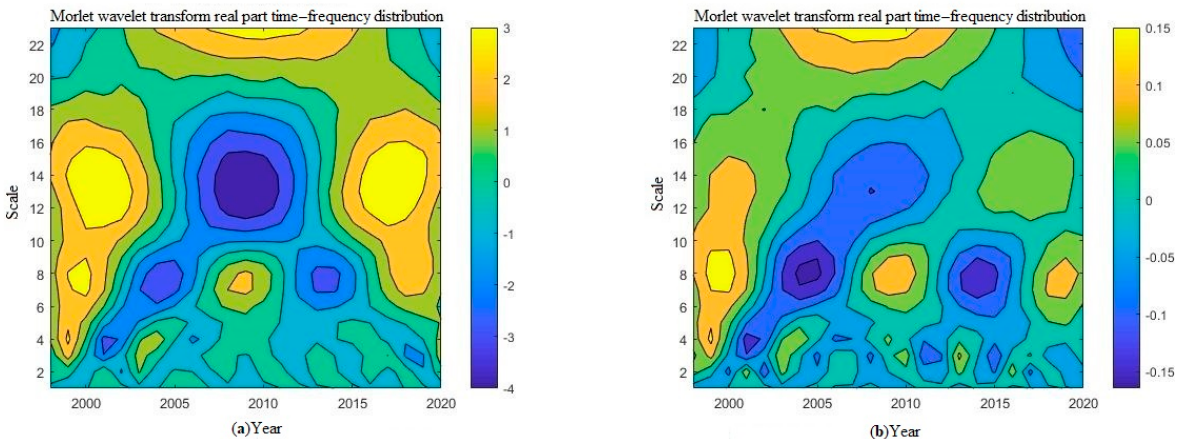
Figure 6. The wavelet model contour map of ( a ) hourly heavy precipitation frequency and ( b ) hourly extremely heavy precipitation frequency during 1998–2020.